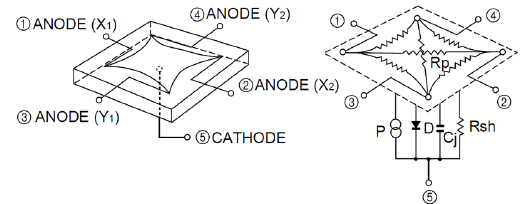
Figure 2. Equivalent circuit of the Position Sensitive Device (PSD) pin-cushion (image courtesy of Hamamatsu, obtained from the PSD technical